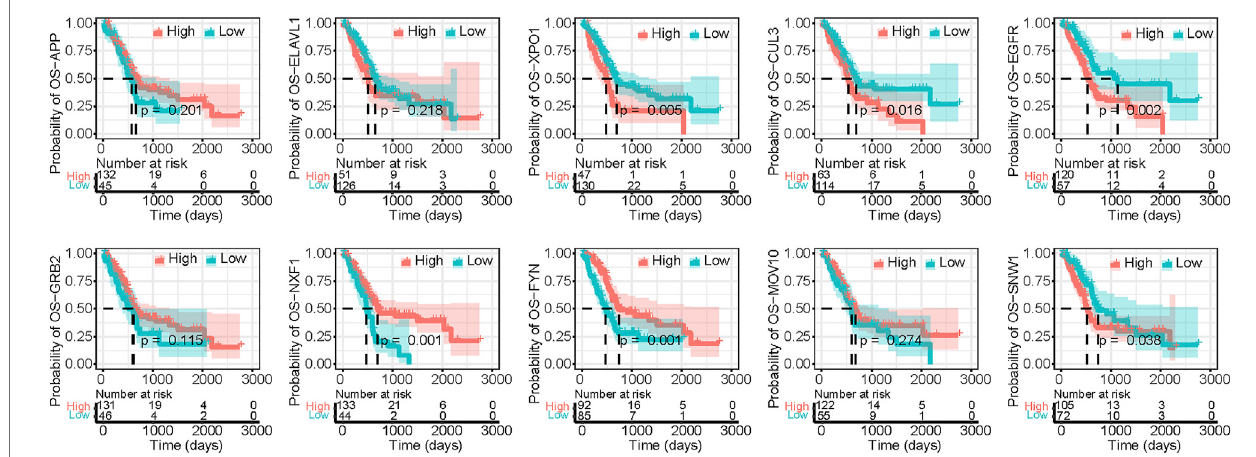
FIGURE 3 | Kaplan – Meier OS curves of genes ranked from 1 to 10.